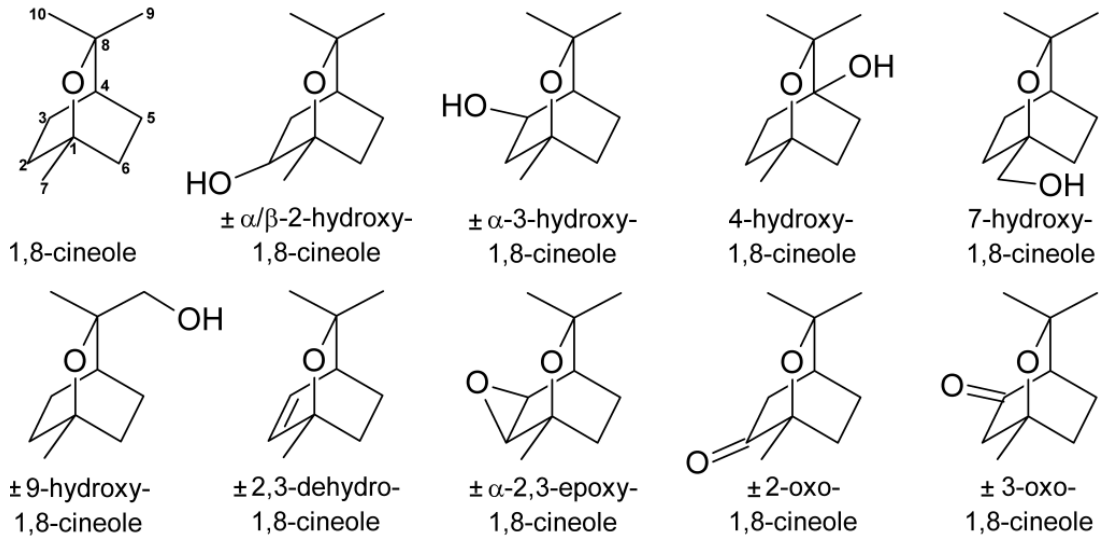
Figure 1. Metabolites of 1,8-cineol identified in human milk